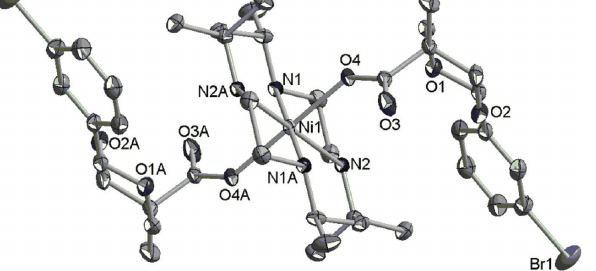
Table 1: Data collection and handling.